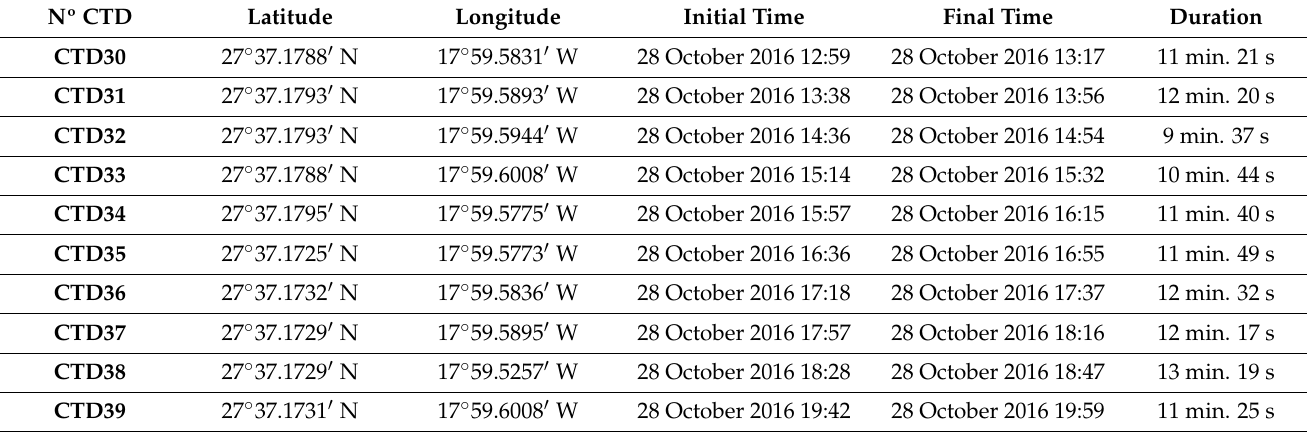
Table 1. The location, duration and date of the 21 CTD time series recorded during the multidisciplinary cruise VULCANO- II-1016. The initial and final times correspond to the entire time in which the oceanographic rosette sampler remained in the water. The duration at the seabed (in minutes and seconds) corresponds to the length of the CTD time series fluctuations without the descending and ascending track. All the minutes until the oceanographic rosette reach the volcano edifice and remain steady one meter above the seafloor were discarded, resulting in significatively shorter time series for CTDs 41, 43 and